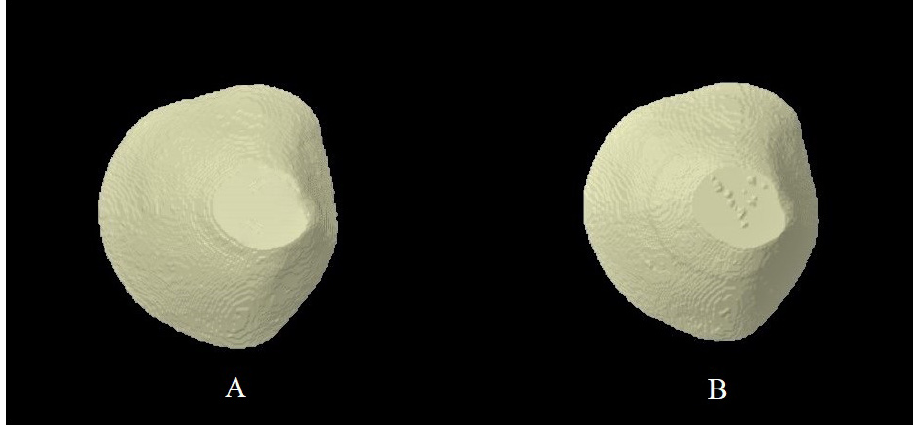
Figure 2. Micro-computed tomography (micro-CT) image of enamel surface A ) Ground and polished B ) Remineralized enamel surface after 24 hours of exposure to a mixture of fluoride toothpaste and distilled water (Courtesy Dr. Saqib Ali, College of Dentistry, Imam Abdulrahman Bin Faisal University, Dammam, Saudi